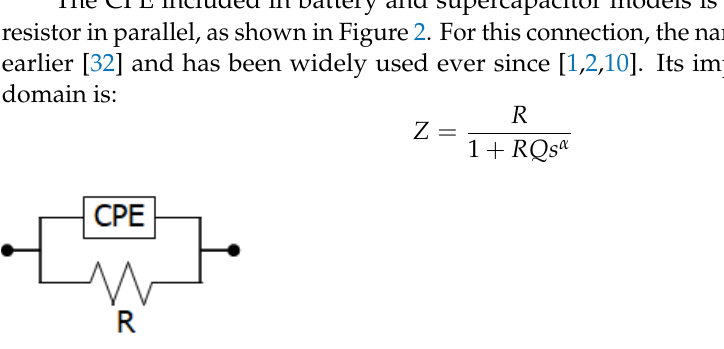
Figure 2. ZARC composed by a resistor and a CPE connected in